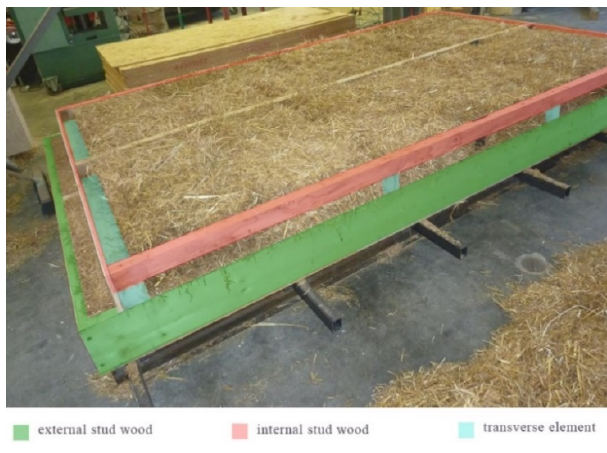
Figure 14. Wooden frame.